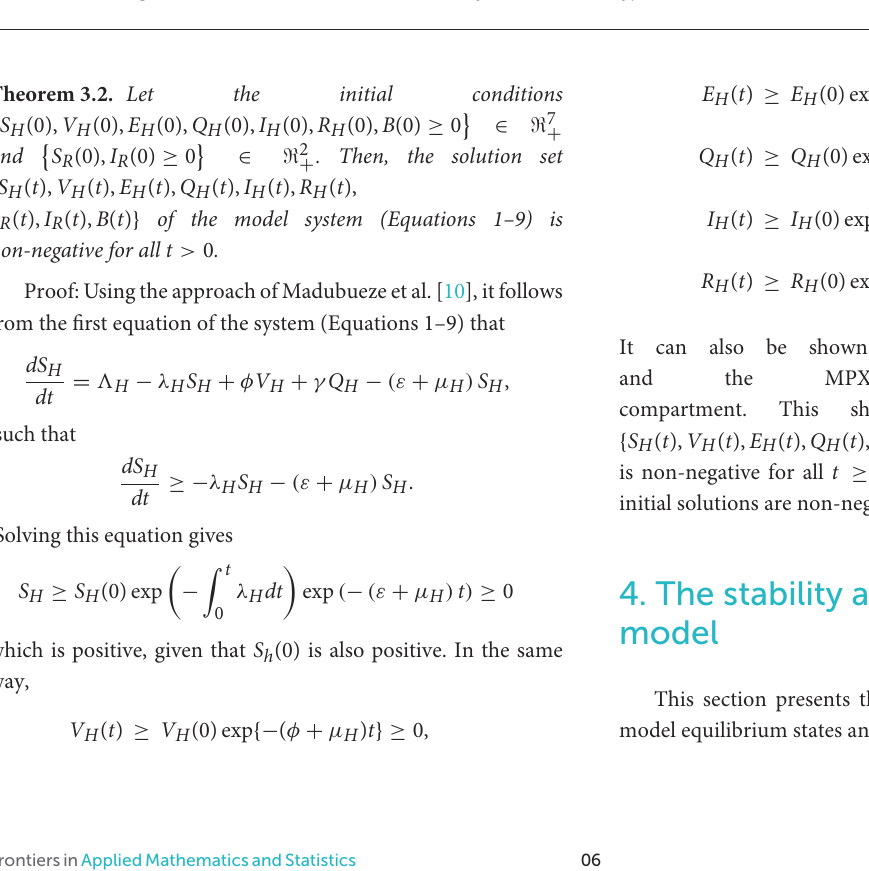
FIGURE1 Model flow diagram for the environmental transmission dynamics of Monkeypox (MPX)